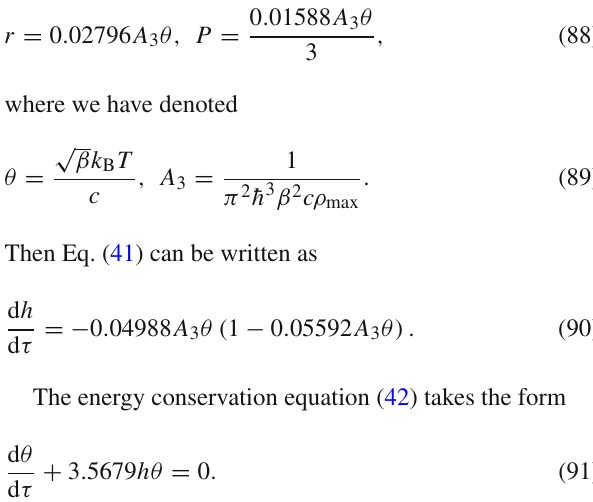
(cid:7) (cid:8) ˜ T (solid curve) and 0 . 0279